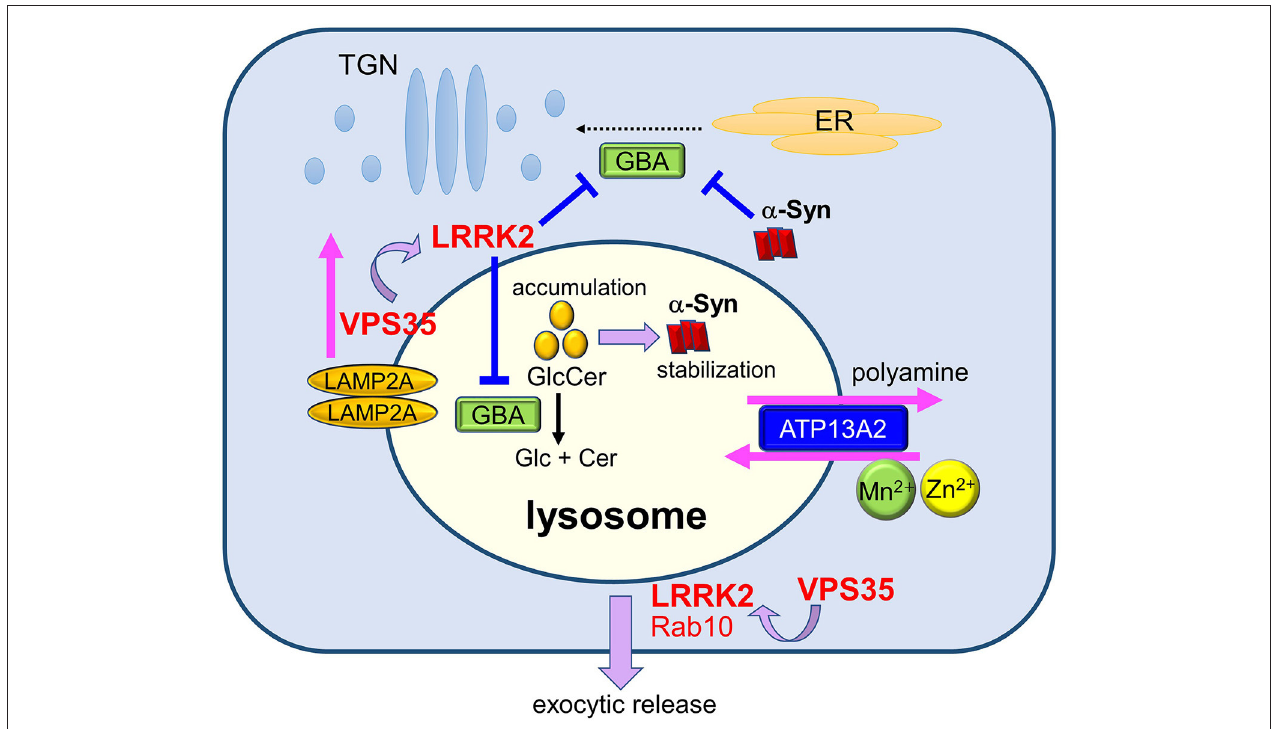
FIGURE 2 | Maintenance of lysosomes by PD gene products and its relevance to PD. Lysosomal homeostasis is regulated by several PD genes such as ATP13A2, LRRK2, GBA, and VPS35. Deficiency in ATP13A2, a P5-type ATPase localized to the lysosomal membranes, is expected to affect lysosomal functions via dysregulated transport of several divalent metal cations and polyamines. LRRK2 functions in the maintenance of stressed lysosomes by facilitating the exocytic release of lysosomal contents together with its substrate Rab10 under lysosomal overload stress. LRRK2 may also negatively regulate the activity of lysosomal hydrolase glucocerebrosidase (GCase). Decreased activity of GCase causes the accumulation of its substrate glucosylceramide (GlcCer), which stabilizes toxic α -synuclein species. Accumulation of α -synuclein has been shown to block ER-to-Golgi trafficking of GCase, causing a further decrease in lysosomal GCase. The retromer component VPS35 mediates the retrieval of a CMA receptor LAMP2A on endolysosomal membranes, and mutation in VPS35 leads to the enhanced degradation of LAMP2A at the lysosomes, causing CMA defects and α -synuclein accumulation. VPS35 mutation also causes the enhancement of LRRK2 kinase activity, which may then affect the lysosomal maintenance and GCase